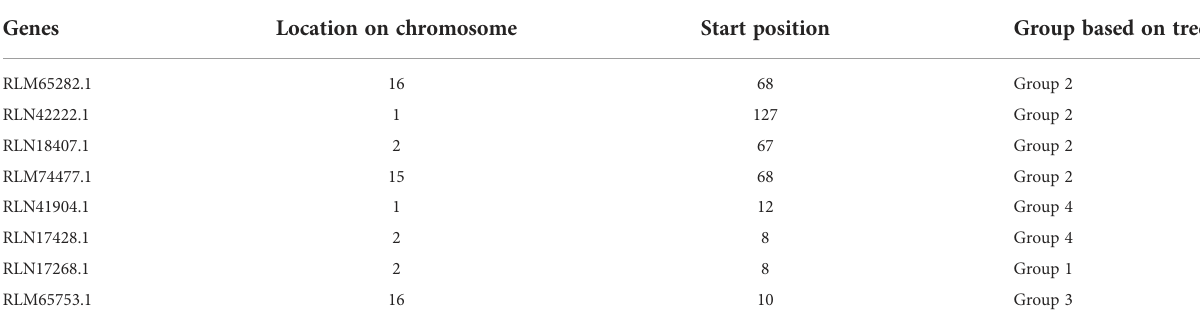
Chromosomal studies of transporters. Genes Location on chromosome Start position Group based on